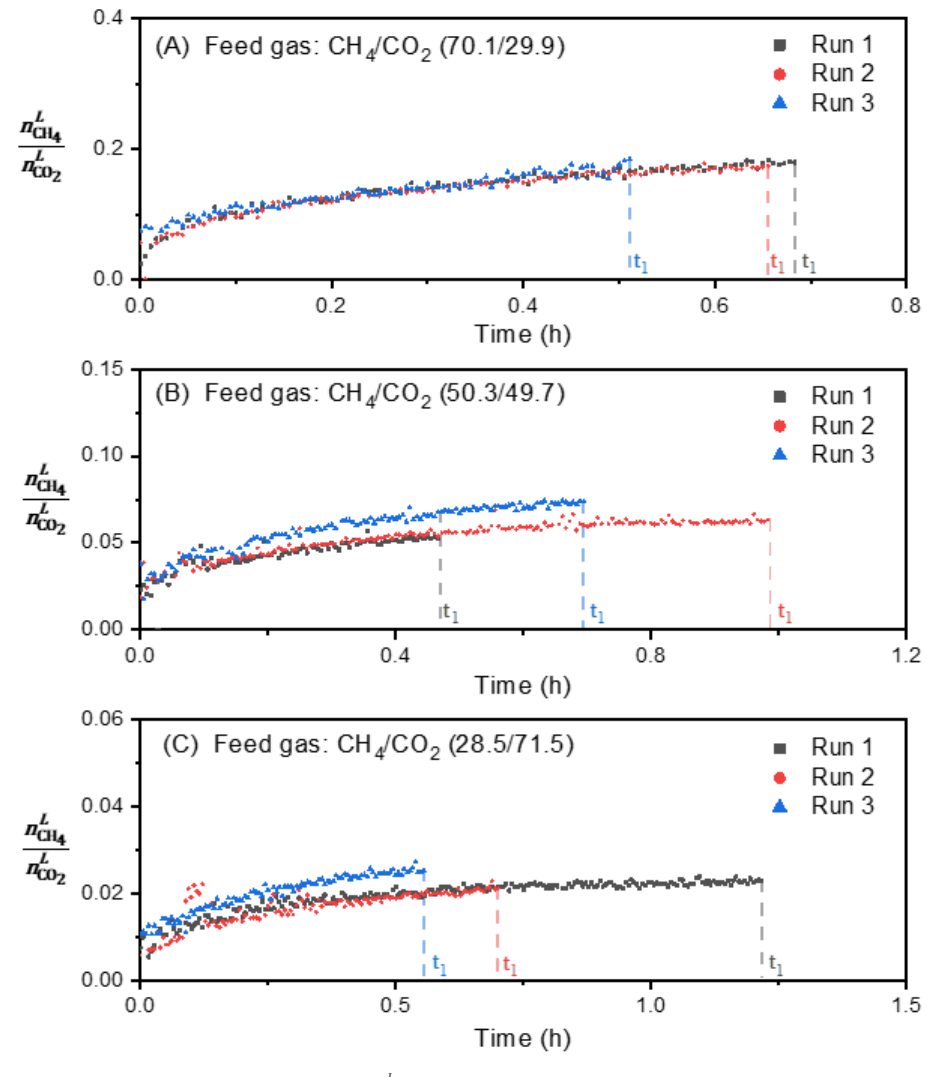
n L CH 4 Figure 7. The evolution of the molar ratio in the liquid water-rich phase (before hydrate formation) (cid:3252)(cid:3257)(cid:3120)(cid:3261) n L CO 2 Figure 7. The evolution of the molar ratio (cid:3041) in the liquid water ‐ rich phase (before hydrate at P ini = 4 MPa and for three di ff erent initial gas compositions. ( A ) feed gas methane fraction 0.701, ( B ) (cid:3041) (cid:3252)(cid:3264)(cid:3118)(cid:3261) formation) at 𝑃 (cid:3036)(cid:3041)(cid:3036) (cid:3404) 4 MPa and for three different initial gas compositions. A) feed gas methane feed gas methane fraction 0.503 and ( C ) feed gas methane fraction fraction 0.701, B) feed gas methane fraction 0.503 and C) feed gas methane fraction 0.285.